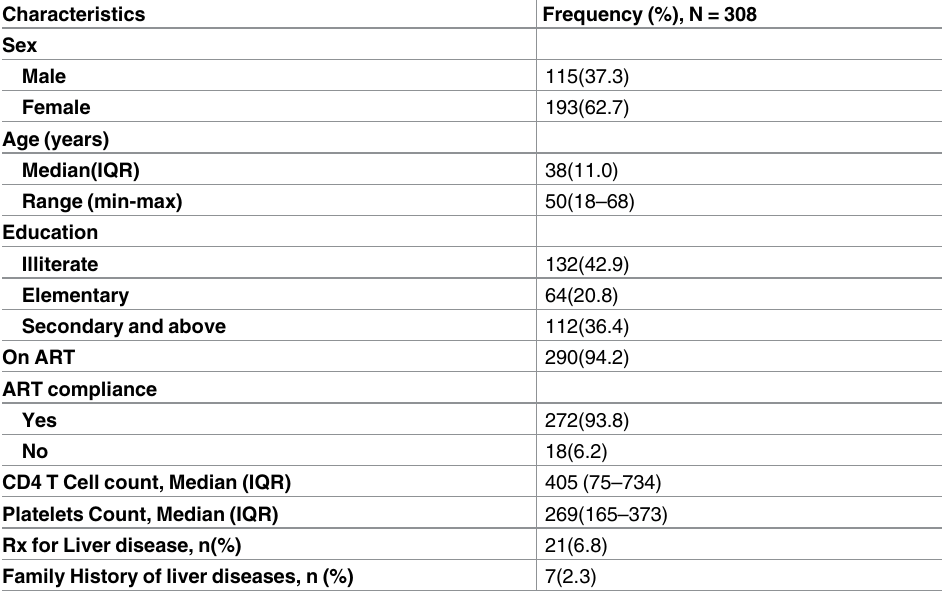
Table 1. Sociodemographic and clinical characteristics of study subjects at ART clinic of the Univer- sity of Gondar Hospital.